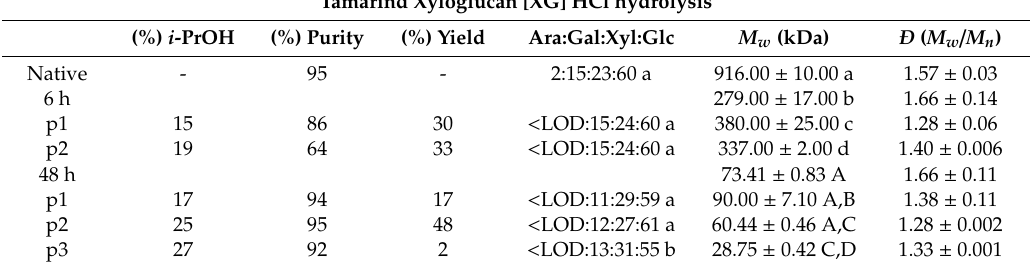
Table 4. M w and Ð variation of XG during 3 and 48 h acid hydrolysis before and after i -PrOH precipitation, with p1, p2 and p3 being the polysaccharide fractions collected during stepwise addition of i -PrOH #